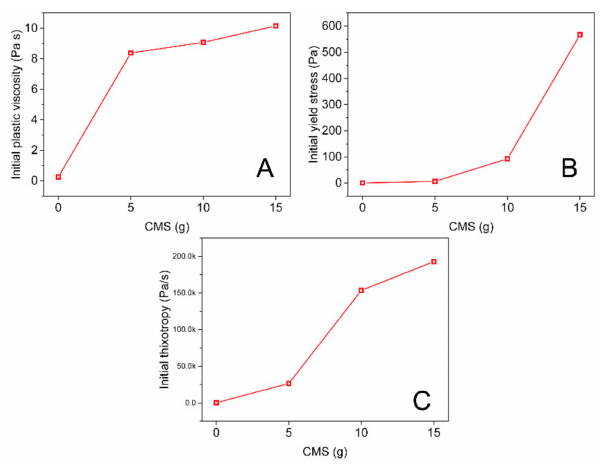
Figure 2. E ff ect of CMS on the initial plastic viscosity ( A ), yield stress ( B ) and thixotropy ( C ).